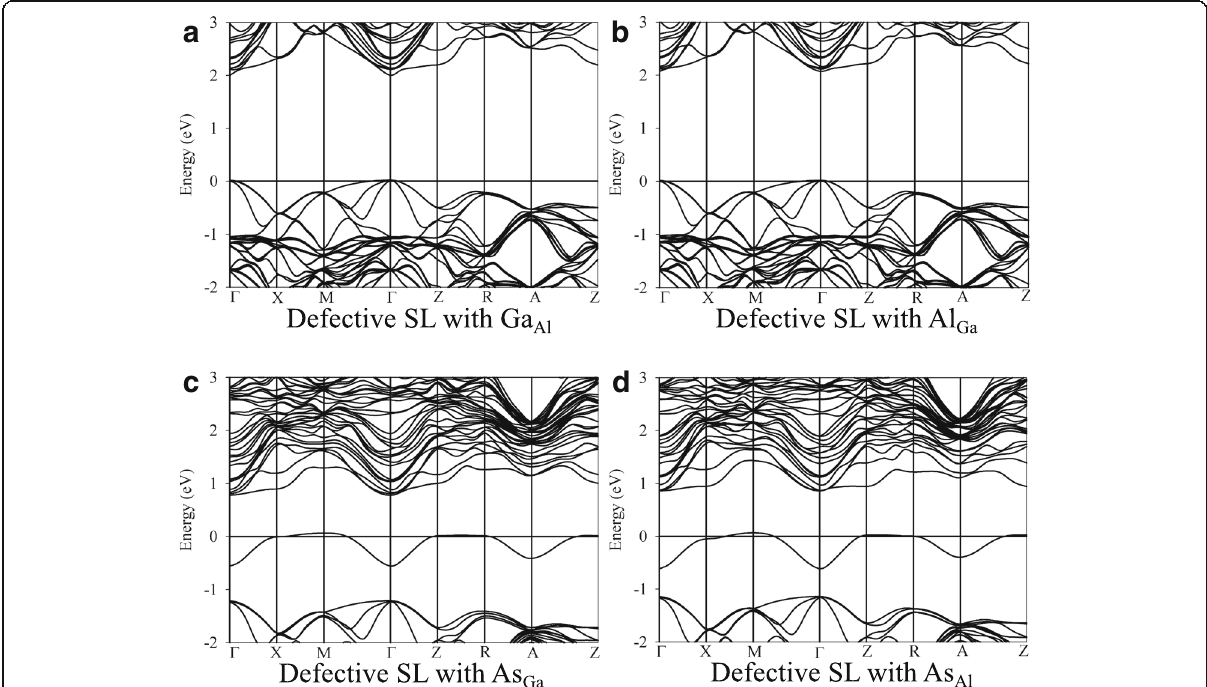
Fig. 5 The band structures of defective GaAs/AlAs superlattice with different antisite defects. a : Ga occupying the Al lattice site; b : Al occupying the Ga lattice site; c : As occupying the Ga lattice site; d : As occupying the Al lattice